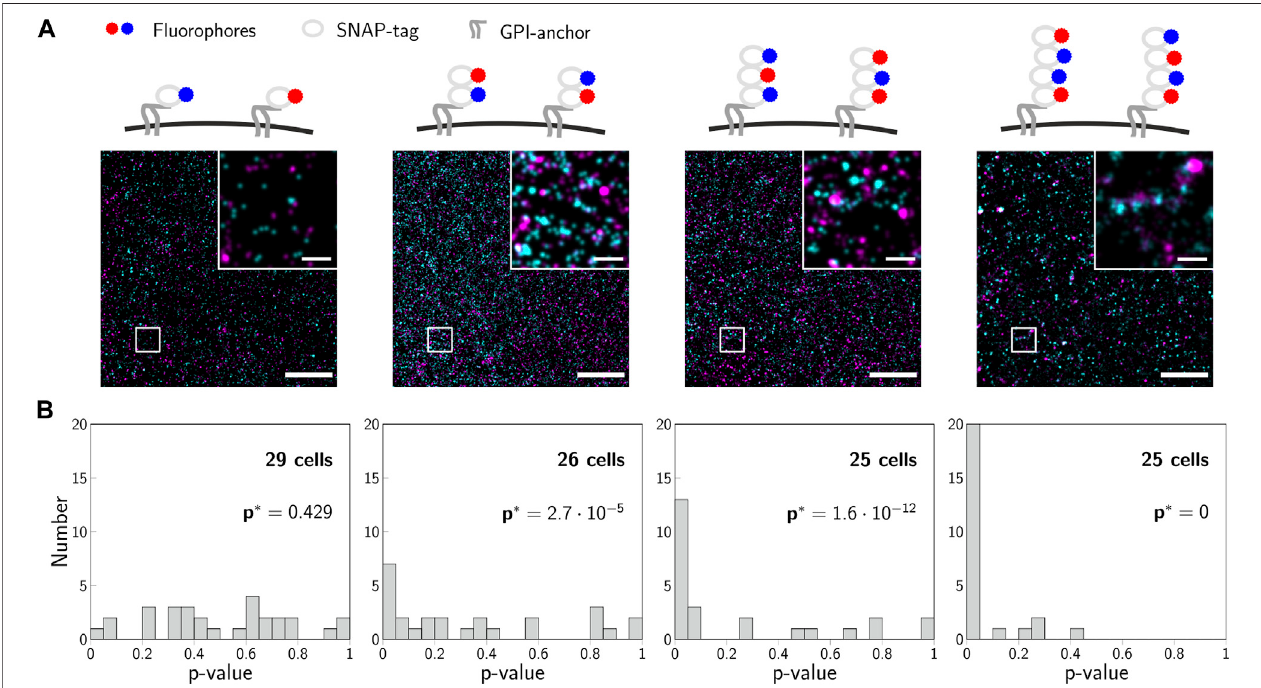
FIGURE 7 | Experimental validation of 2-CLASTA. (A) Illustrations and representative localization maps recorded for SNAP-monomers, -dimers, -trimers and -tetramers(lefttoright).Scalebars:250 nm(inset)and2 μ m. (B) Histogramsof p -valuesobtainedformultiplerecordedcells,whichwereanalyzedindividuallywiththe2- CLASTA method. For each SNAP construct, we also calculated the joint p -value p * according to Eq. 2 , with the threshold p 0 = 0.05. Panels (B) and (C) adapted from (Arnold et al., 2020), CC BY 4.0